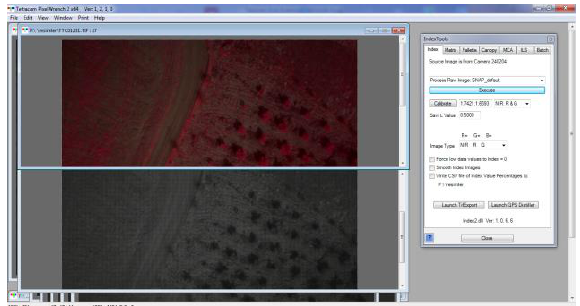
Figure 2a. PixelWrench interface